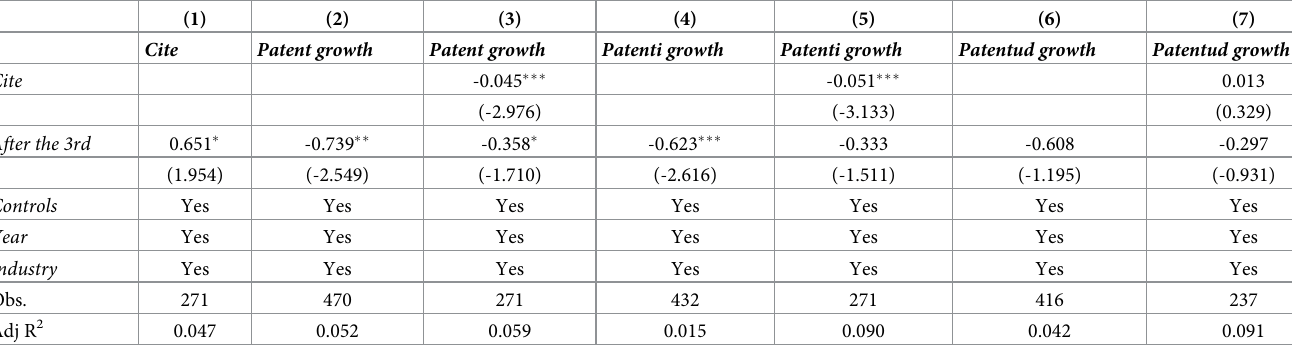
Table 10. Equity incentive and innovation output: Firms with vesting periods longer than three